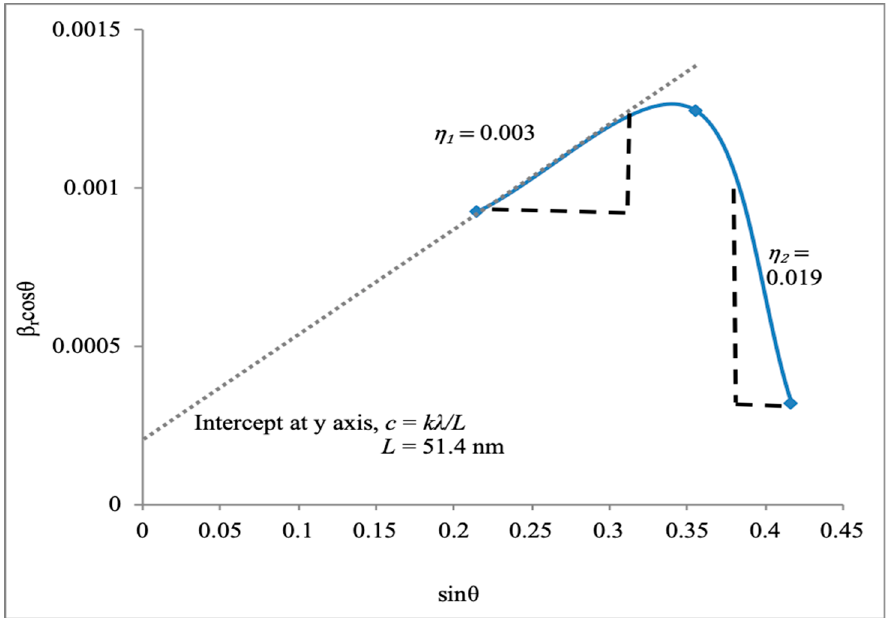
Figure 9. Plot of β r cos θ versus sin θ from XRD data of the 16 min sample.